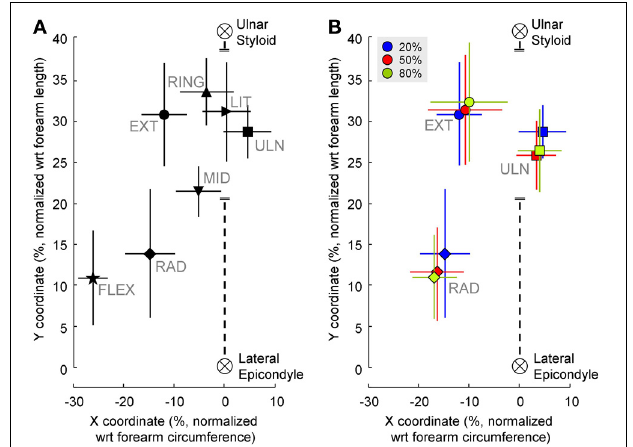
FIGURE 4 | (A) Position of the clusters’ barycenter identified from EMG amplitude distributions during the contractions tested. For wrist extension, radial and ulnar deviation only the position of the barycenter extracted from the 20% MVC contraction is shown. (B) Position of the clusters’ barycenter identified from EMG amplitude distributions during wrist extension and radial deviation contractions at different force levels. The black, dashed line represents the third column of electrodes. The coordinates of each subject were normalized with respect to the forearm circumference (X-axis) and forearm length (Y-axis). Symbols represent the mean values of X and Y coordinates of all subjects pooled together, vertical and horizontal lines are the standard deviation.